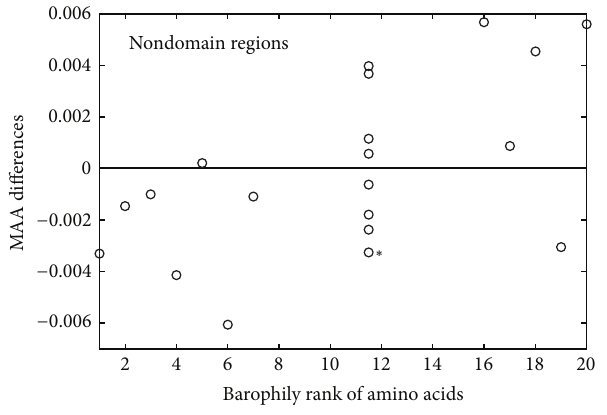
Figure 4: MAA analysis of nondomain regions shows there is no significant difference in barophilic and nonbarophilic amino acid use between the two organisms. Statistical significance is marked with stars as described in Figure 2. A total of 1,229 P. abyssi and 1,339 P. furiosus sequences were